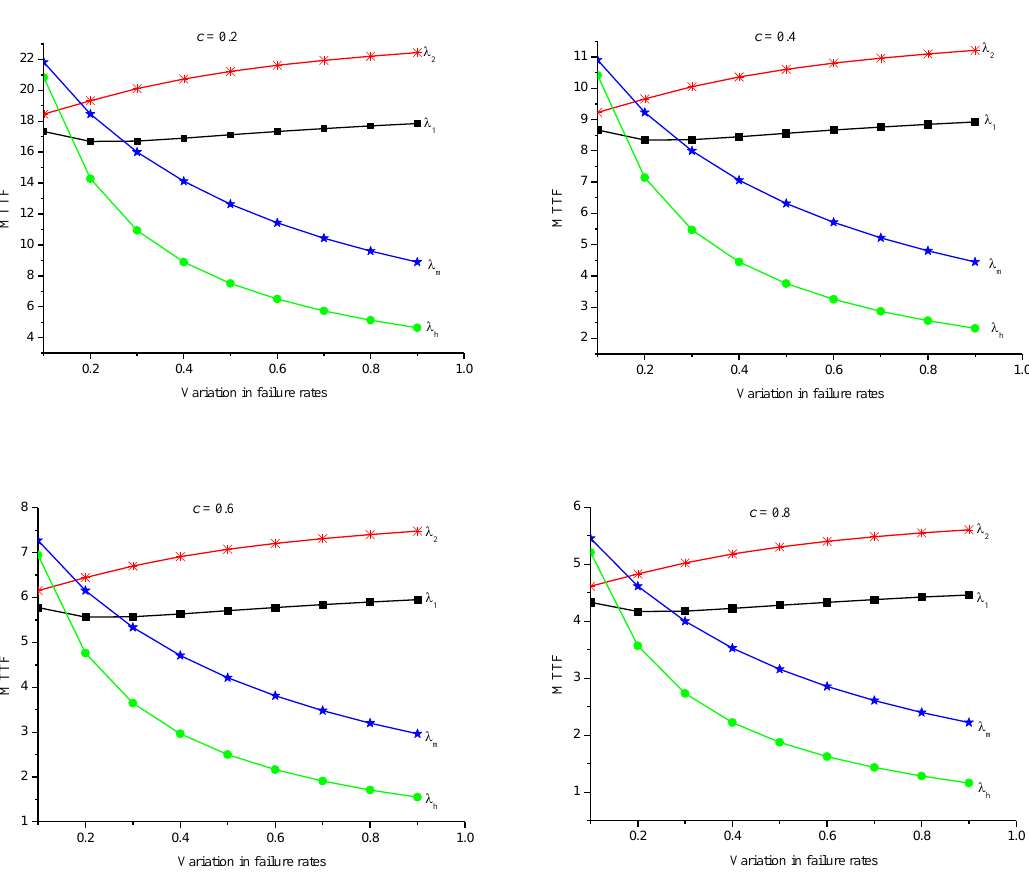
Figure 12. MTTF of the system with coverage.